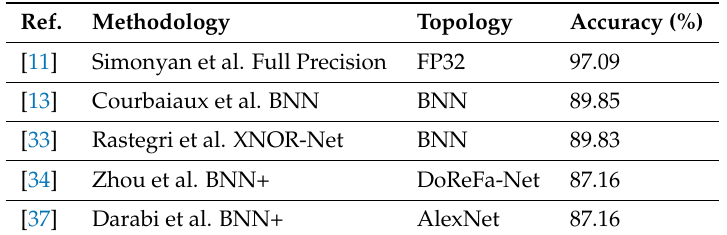
Table 1. Accuracy of different methodology on the CIFAR-10 database.